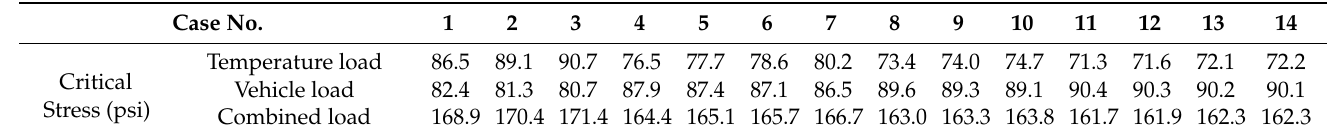
Table 10. Critical stresses due to temperature and vehicle loadings under various support property compositions with a composite k -value of 300 psi/in (81.3 MN/m 3 ) (1 psi = 6.89 kPa). Case No.